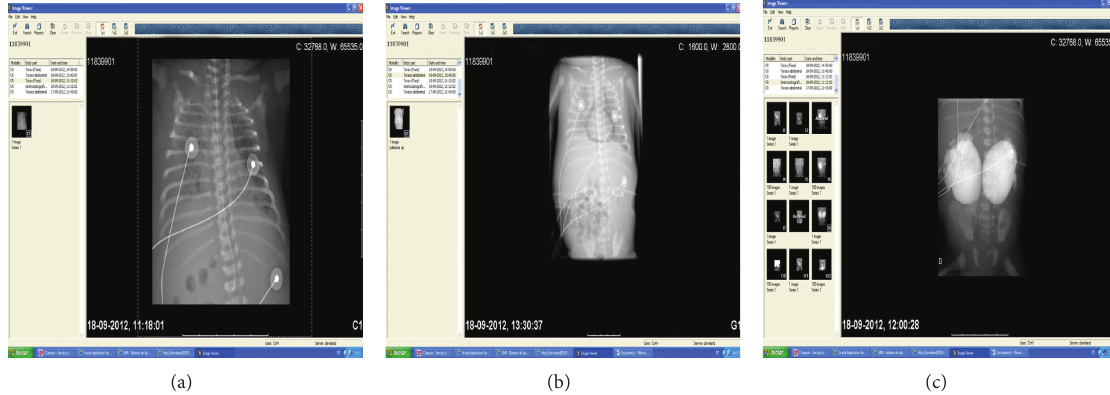
F 2: Case report 3: (a) chest radiograph with pulmonary ground glass opacities and right pleural effusion. (b) Chest radiograph showing pneumomediastinum. (c) Percutaneous nephrostomy using water-soluble contrast revealing very severe bilateral